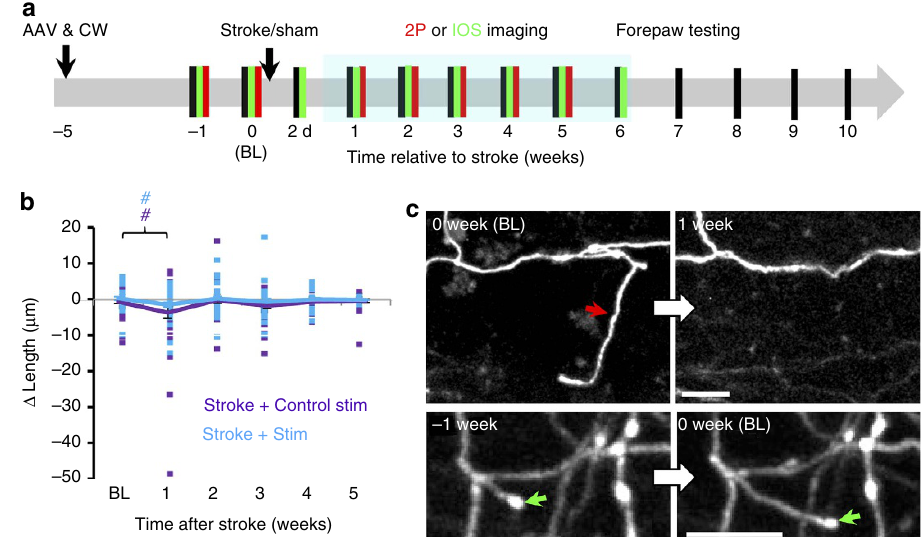
Figure 4 | Restructuring of axonal branches after stroke. ( a ) Timeline for experiments. Behavioural tests of forelimb function (black lines) were regularly conducted (usually at weekly intervals) in sham or stroke-affected mice that underwent two-photon imaging of thalamocortical structure (red lines) or intrinsic signal optical imaging (green lines). Behavioural tests were always conducted the day before imaging. ( b ) Graph plots the growth and retraction of thalamocortical axonal branches in stroke-affected mice with or without optogenetic stimulation (Stroke þ Control stimulation: n ¼ 40 branches; Stroke þ stimulation: n ¼ 38 branches). The average change in branch length is shown with solid lines. ( c ) In vivo time lapse images (maximal intensity z-projection) showing examples of axonal branch elimination (upper) and growth (lower). # P o 0.05 based on t -tests comparing post-stroke time points in each group designated by colour to respective BL values. Scale bar, ( c ) 10 m